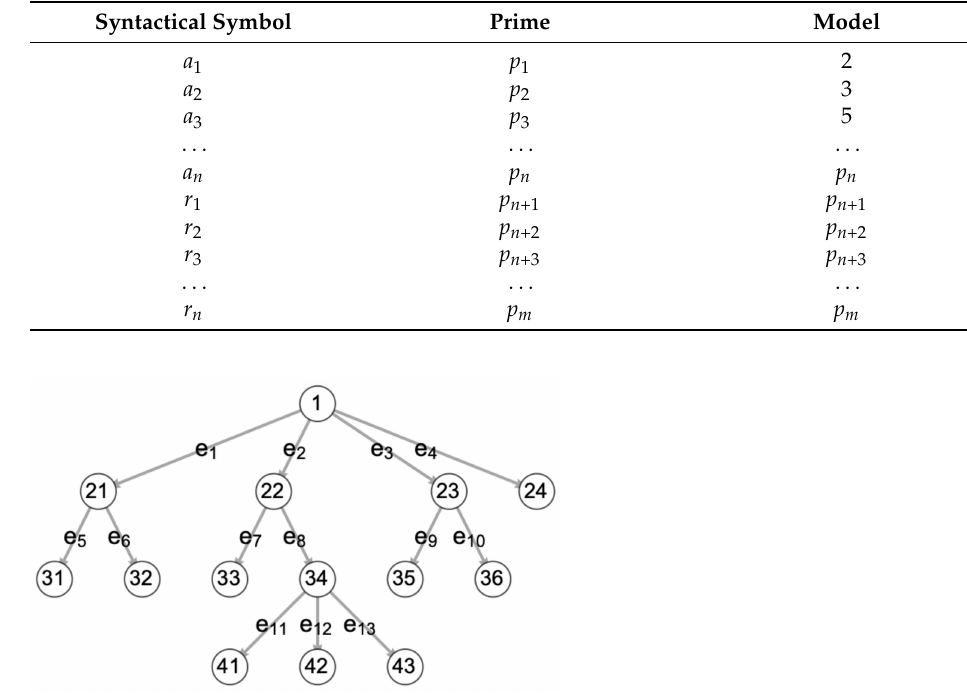
Table 2. Arithmetization of an axiomatic behavior control system.